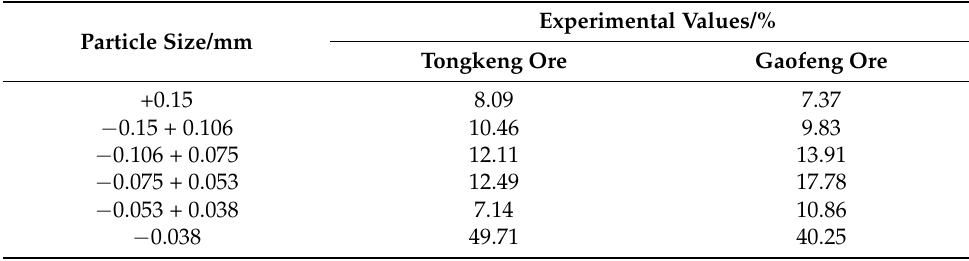
Table 7. Experimental values of the yields of grinding product.